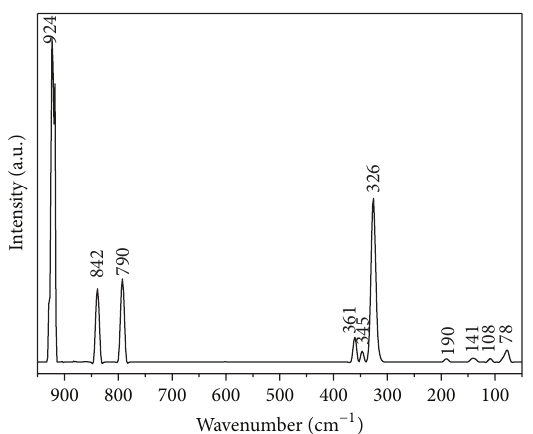
Figure 3: Raman spectrum of as-prepared nano-BaWO 4 prepared by combustion technique.